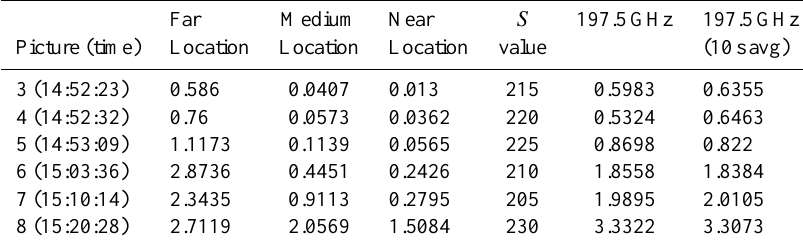
Table A1. Summary of changes in optical depth at visible wavelengths and